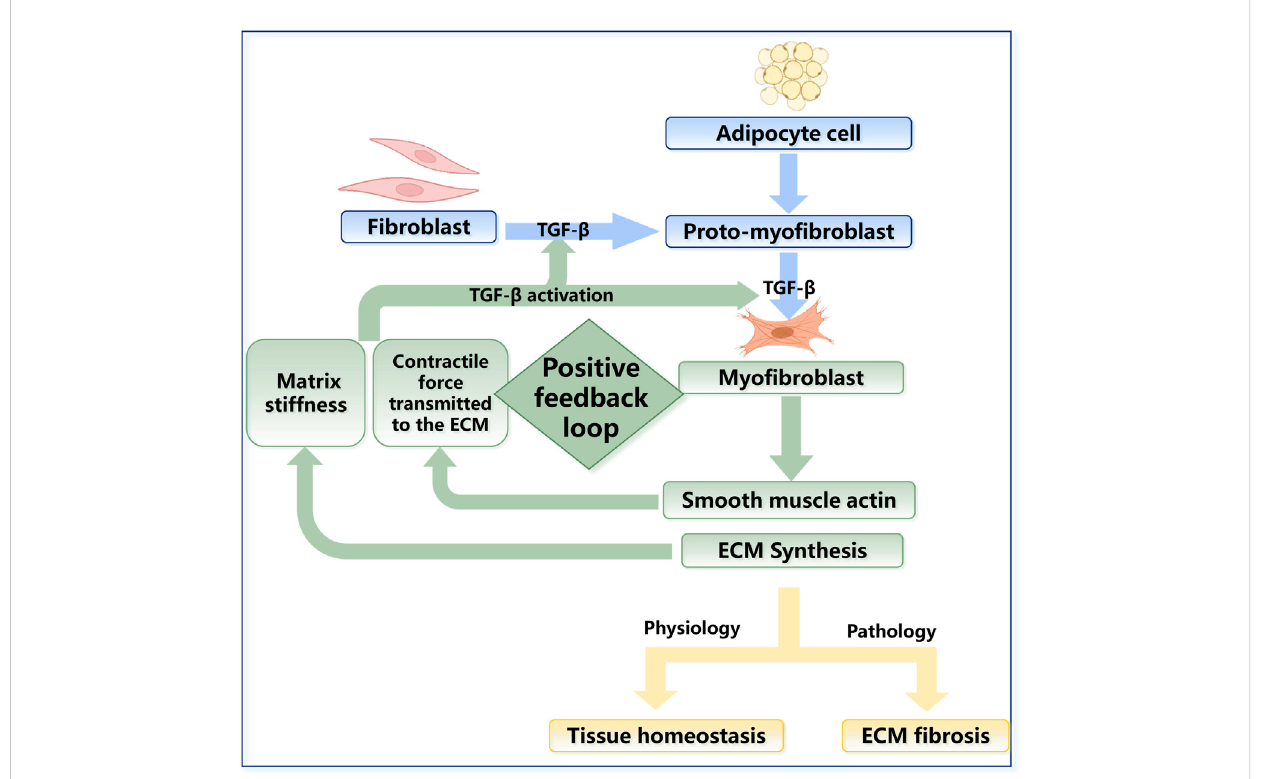
FIGURE 3 The regulation in fi broblast activation. The fi broblasts derived from bone marrow can differentiate into an intermediate stage called protomyoblasts and then into myo fi broblasts. Myoblasts can synthesize many kinds of molecules that contribute to mechanical changes in the ECM. In physiology, fi broblasts are vital to tissue homeostasis, while their excessive activation can lead to fi brosis in pathology. The rate of transformation to protomyoblasts and myo fi broblasts is related to the mechanical changes in turn, which could lead to positive feedback. Mechanical changes can also activate the secretion of TGF- β , which is a crucial factor during fi